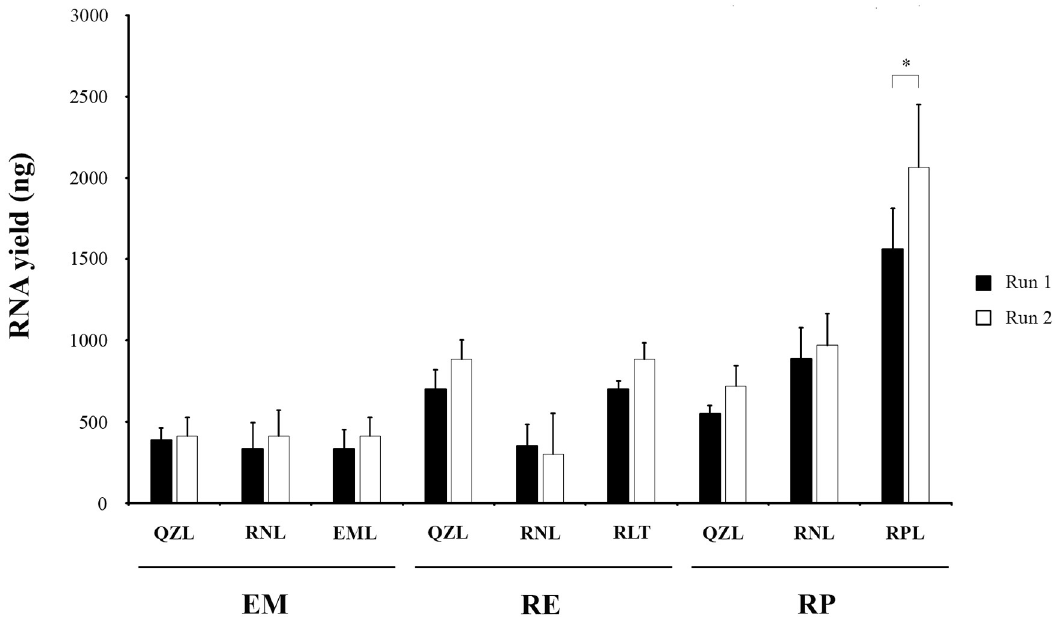
Fig 3. RNA yield according to 2100 Bioanalyzer from PBMCs stored in three different storage media and after three different RNA extraction kits performed on two separate dates (Run 1 and Run 2). Error bars represent the standard deviations of results from three independent extractions. Statistically significant differences are marked with an asterisk ( p < 0.05) ( t test for paired samples). EM: NucliSENS easyMAG; RE: RNeasy Mini Kit; RP: RiboPure RNA Purification Kit–blood; QZL: QIAzol; RNL: RNAlater; EML: easyMAG lysis buffer; RLT: RNeasy lysis buffer; RNL: RNAlater; RPL: RiboPure RNA Purification Kit–blood lysis